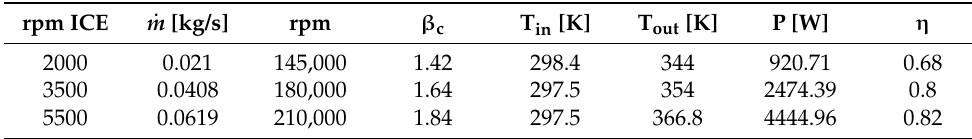
Table 2. Compressor (GT)12 compressor operation at different internal combustion engine (ICE) engine rotation